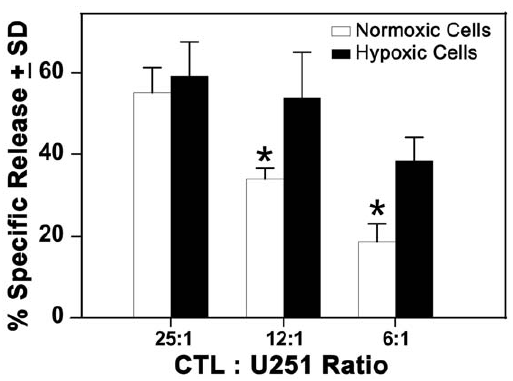
Figure 8. Hypoxic U251 cells are killed better by Whsc2 specific human CTLs. HLA-A0201 restricted CTLs were generated in vitro against the Whsc2 103–111 peptide. The U251 target cells were either grown under normoxic or hypoxic conditions for 1 week. The target cells were radio-labeled with Cr 51 . The lymphocytes were incubated with the target cells for 6 hrs at 37C in quadruplicate cultures. The data is presented as % Specific Release 6 Standard Deviation (SD). Asterisks indicate P , 0.05 as determined by a Student’s t test to show the statistical differences between the cytotoxic data at either the respective 12:1 or 6:1 effector:target ratios.